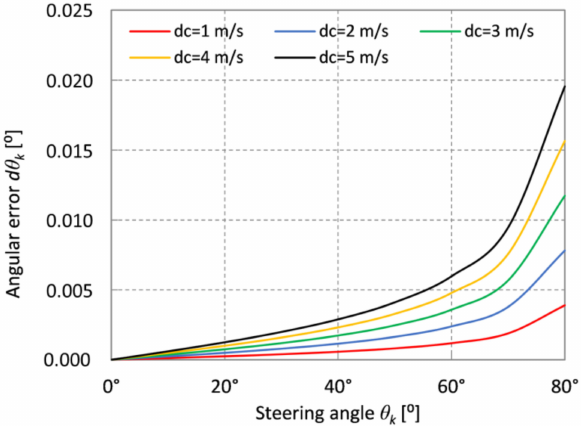
Figure 3. Beam steering sensitivity to surface sound speed error. Outer beams of the multibeam echosounder are subject to greater angular error d θ k than the inner beams. The increased uncertainty of depth measurement in the oblique beams forces the necessity to limit the usable swath angle of the multibeam system while performing bathymetric